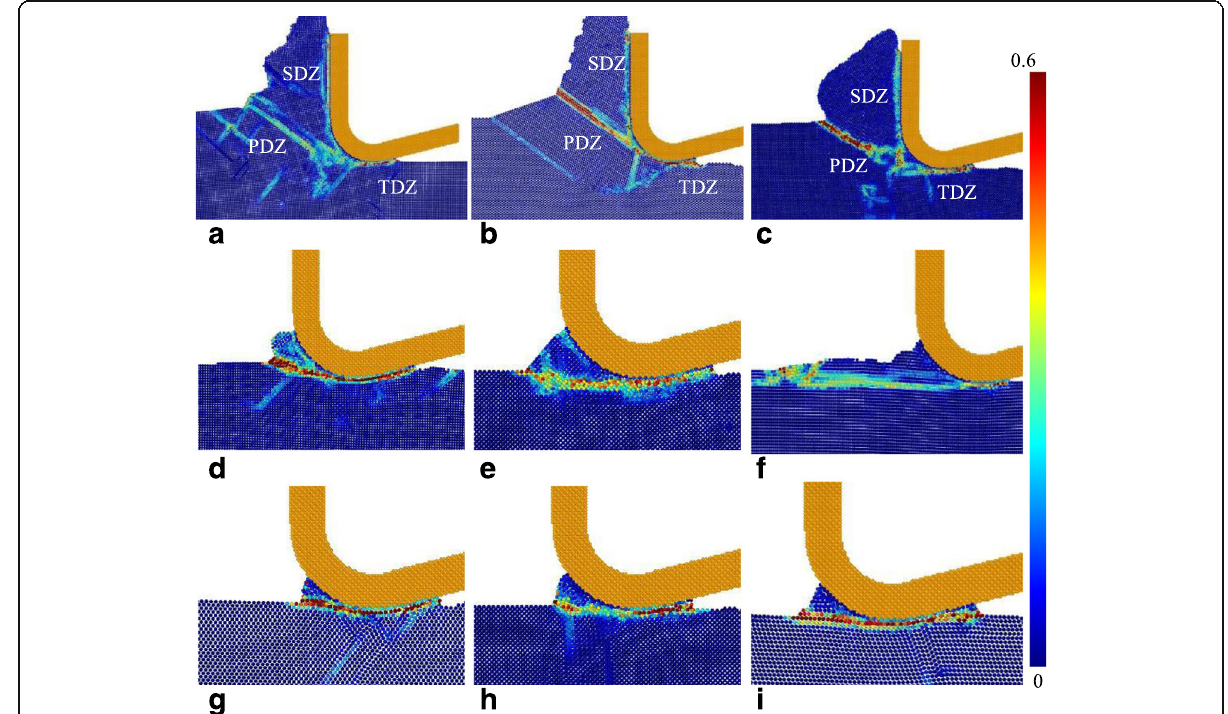
Fig. 14 Shear strain of different surface generation mechanisms. a {100}<001>, UCT: 5 nm. b {110}<001>, UCT: 5 nm. c {110}<1-10>, UCT: 5 nm. d {100}<001>, UCT: 0.75 nm. e {110}<1-10>, UCT: 0.5 nm. f {111}<1-10>, UCT: 0.75 nm. g {100}<011>, UCT: 0.5 nm. h {110}<1-10>, UCT: 0.25 nm. i {111}<11-2>, UCT: 0.25